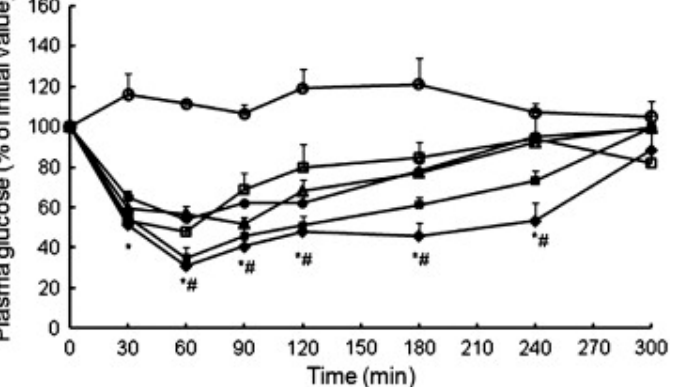
Figure 3. Hypoglycemic profiles following intratracheal administration to rats of microencapsulated insulin-loaded chitosan nanoparticles (INS-loaded CS NPs) prepared using chitosans of different MW (CS 113 and CS 213), and control formulations (mean ± SD, n ≥ 3): ( ◊ ) Microencapsulated INS-loaded CS NPs—CS 113; ( ▪ ) Microencapsulated INS-loaded CS NPs—CS 213; ( ◦ ) Microencapsulated blank (without insulin) CS NPs—CS 113; ( □ ) Mannitol microspheres containing INS; ( Δ ) Suspension of INS-loaded CS NPs—CS 113; ( ● ) INS solution in PBS pH 7.4; * Statistically significant differences from microencapsulated blank CS NPs ( p < 0.05); # Statistically significant differences from INS solution ( p < 0.05). Reprinted with permission from [47].